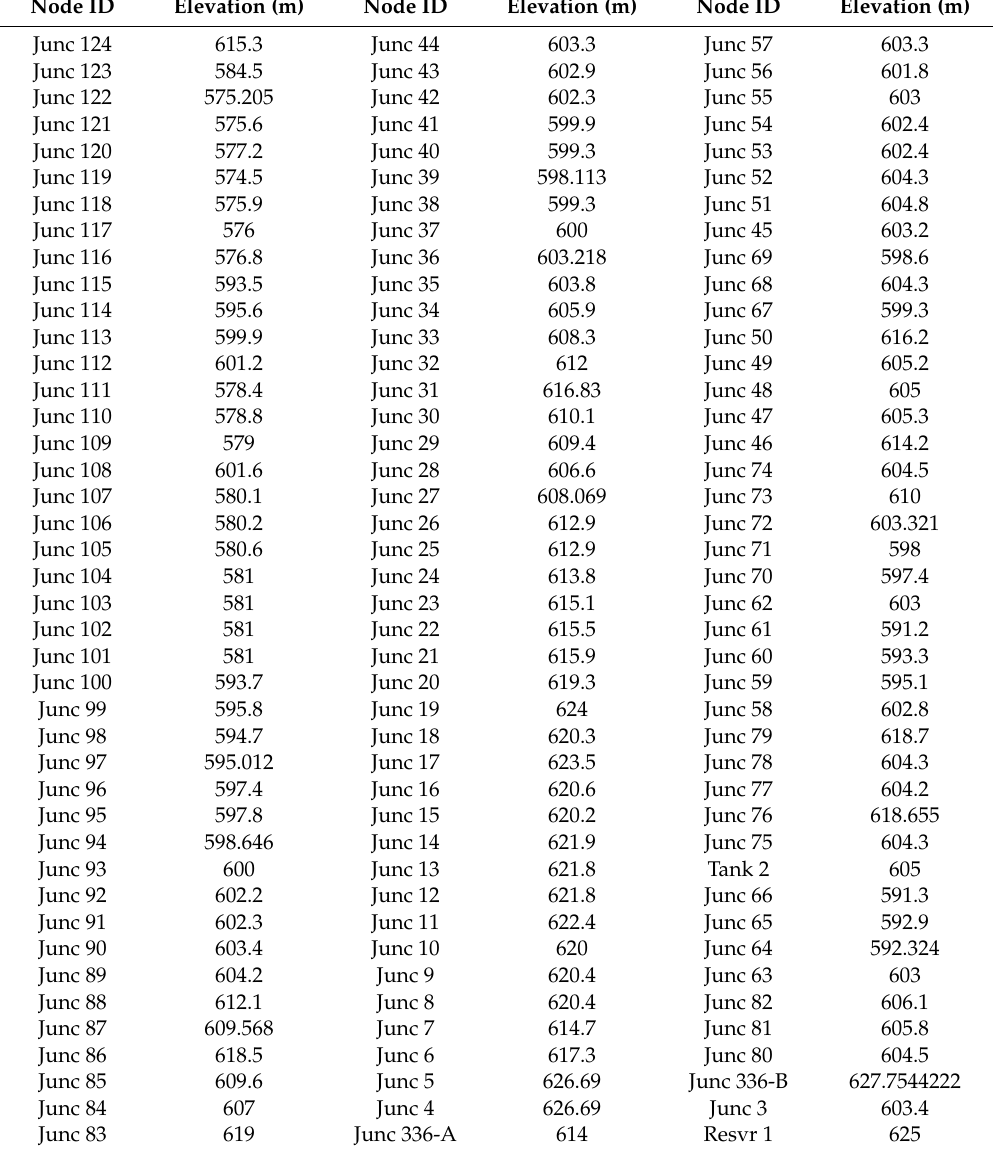
Table A2. Details of nodes and their elevation Campos do Conde II water distribution network,